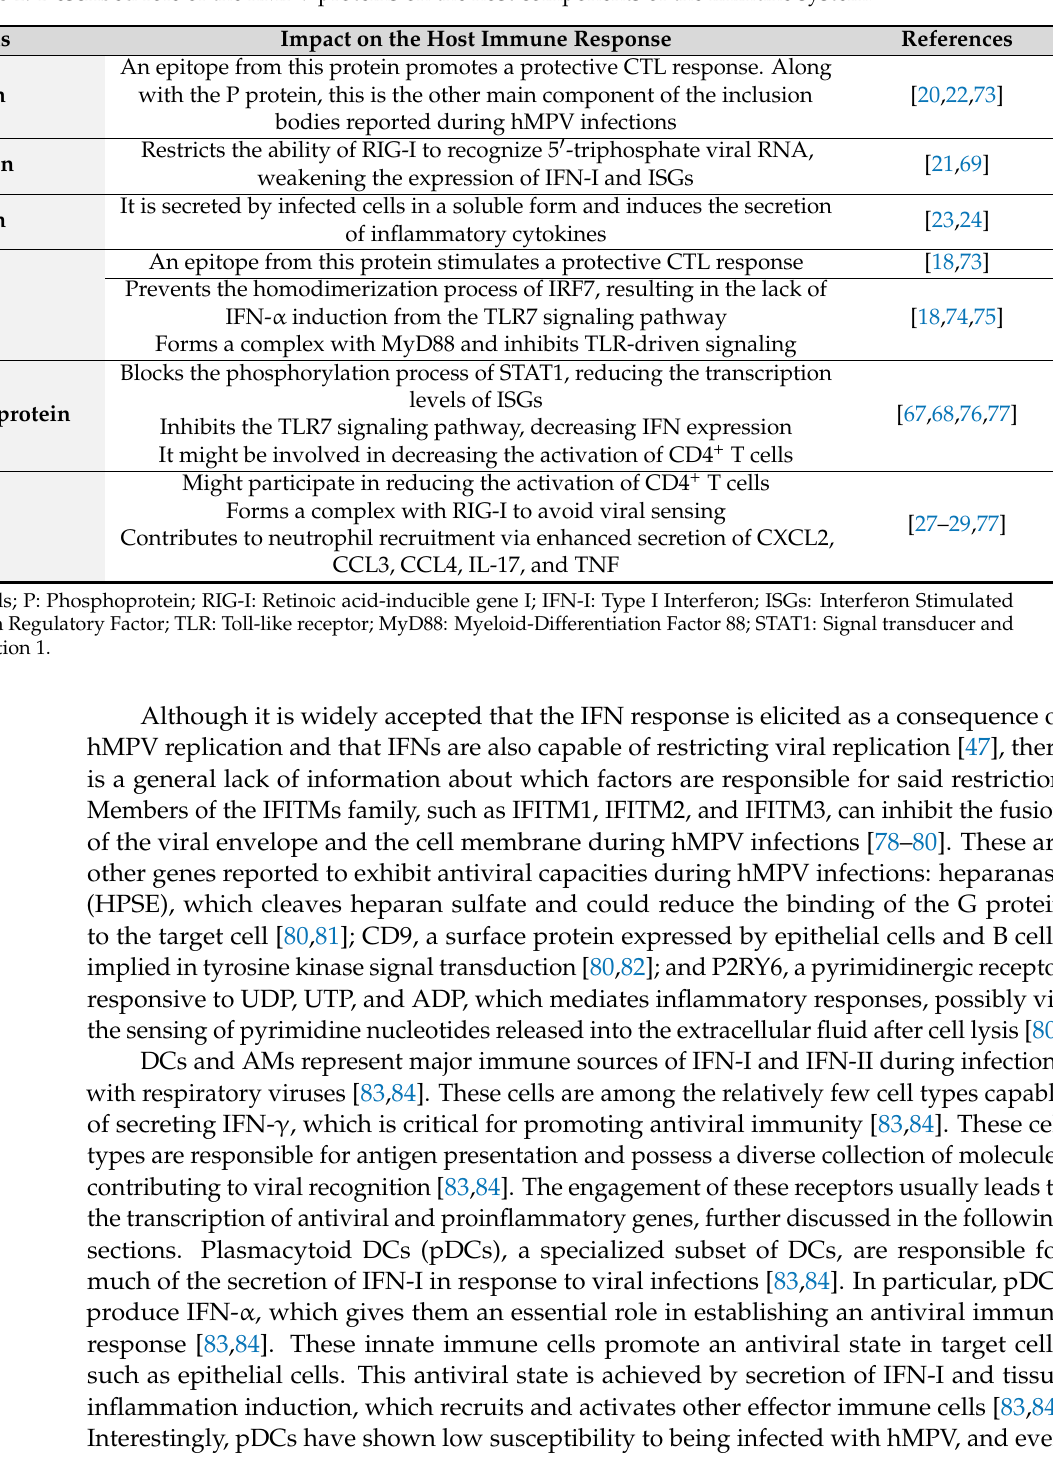
Table 1. Described role of the hMPV proteins on the host components of the immune